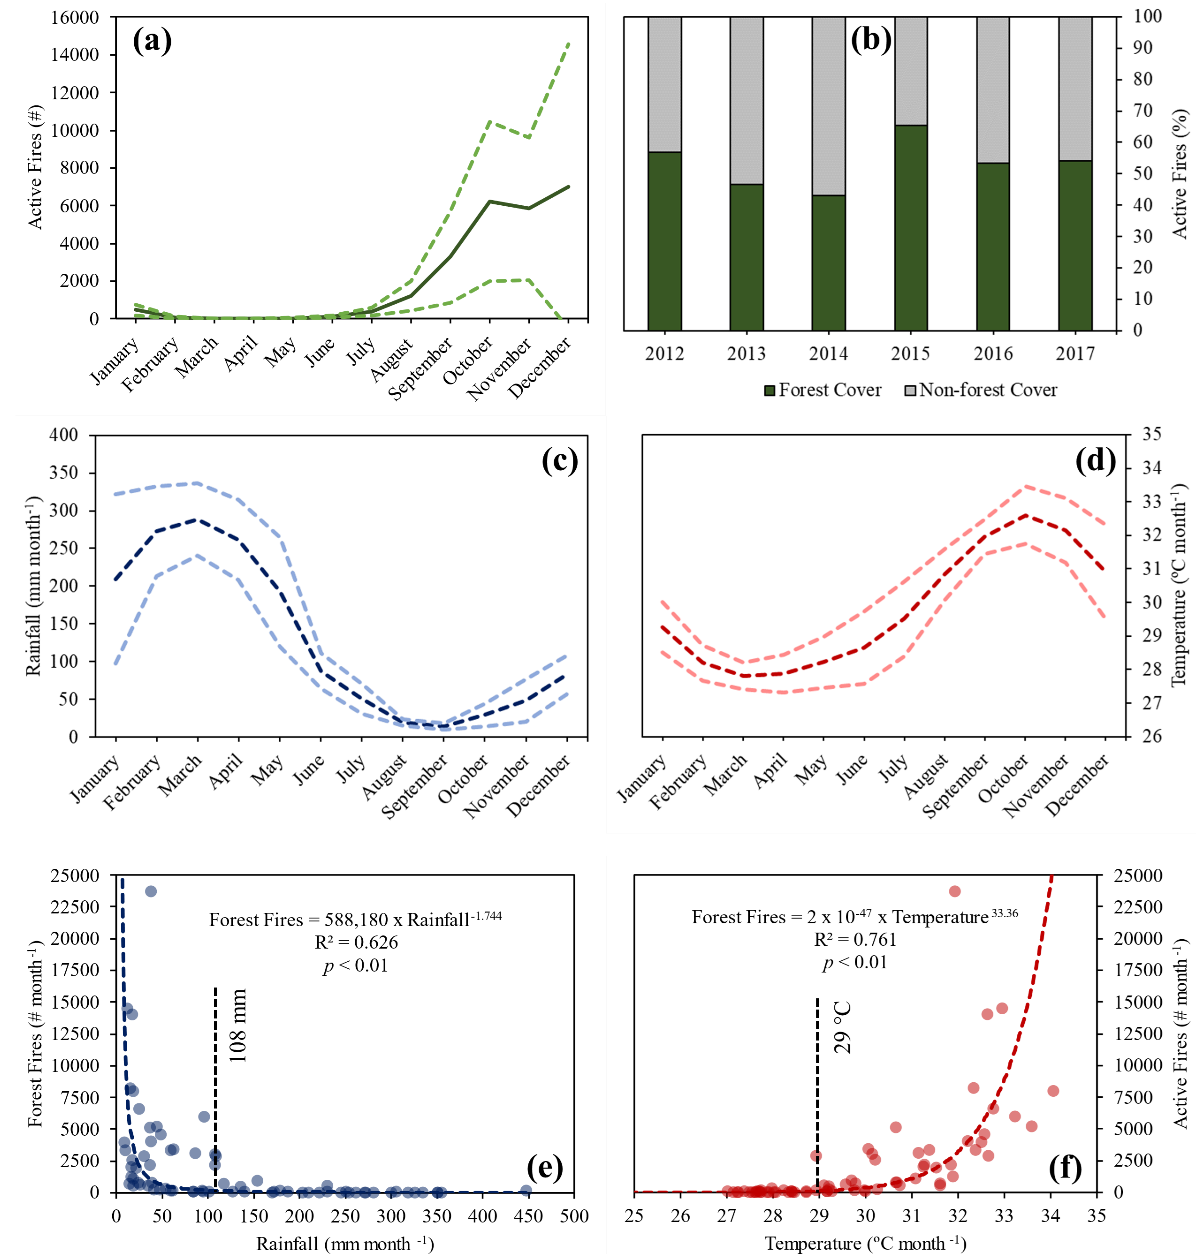
Figure 4. ( a ) Average monthly pattern of active fires in forest cover areas for the 2012–2017 period in the Amazon region of Maranh ã o, Brazil. ( b ) The proportion of active fires registered annually in forest and non-forested cover during the 2012–2017 period. ( c ) The monthly average rainfall in the 2012–2017 period. ( d ) The monthly average temperature in the 2012–2017 period. ( e ) Regression of the relationship between the monthly average rainfall and the monthly total number of active fires in forest cover in the 2012–2017 period. ( f ) Regression of the relationship between the monthly average temperature and the